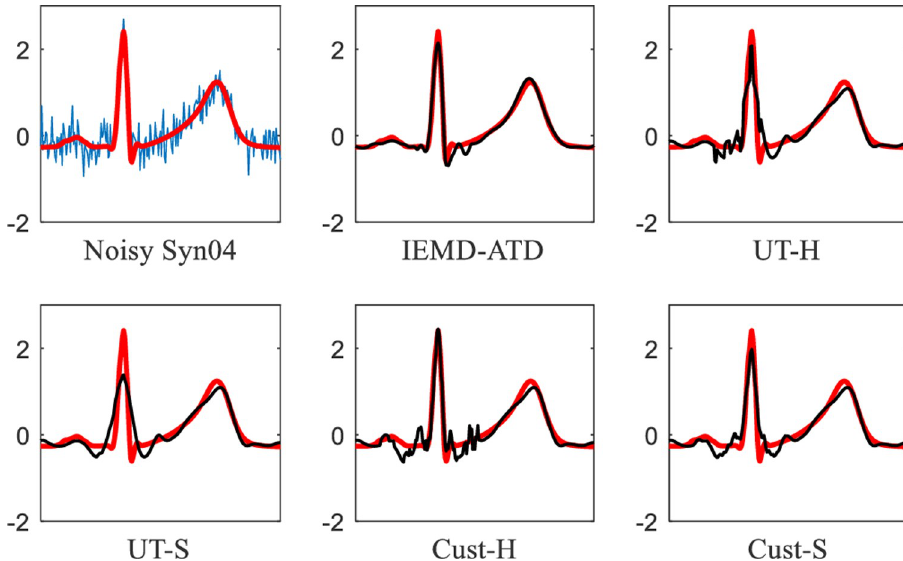
Fig 12. Details of waveforms between 7.05 and 7.7 seconds from Fig 11.